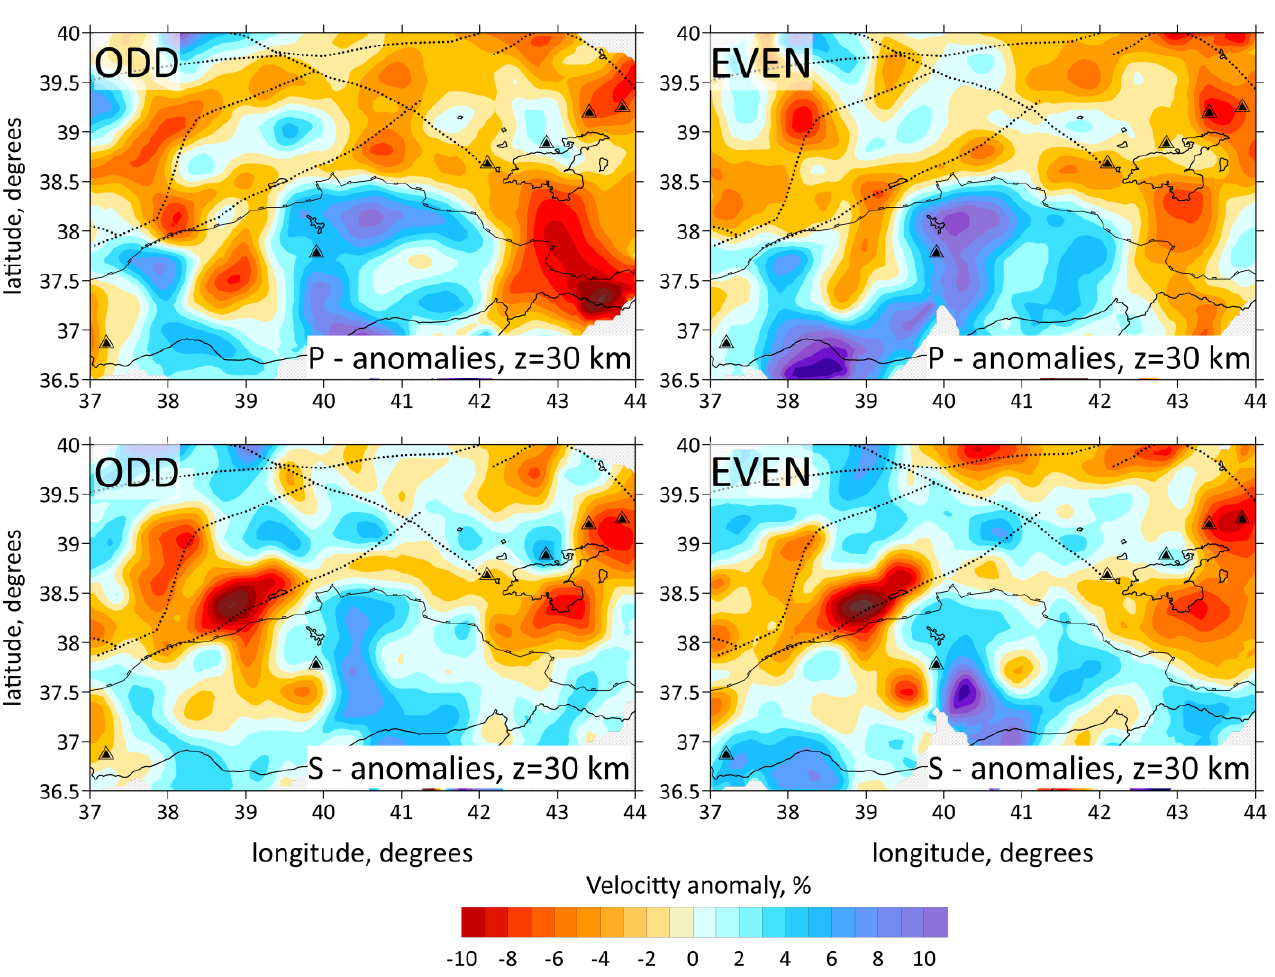
Figure 5. Odd/Even events test.